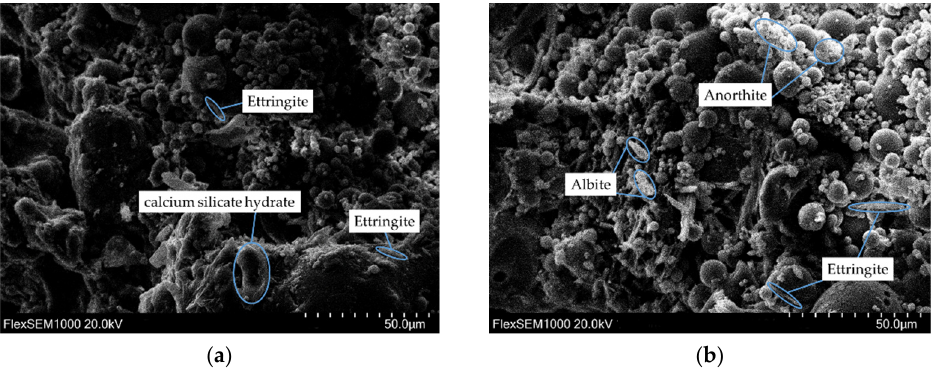
Figure 11. Scanning electron microscopic images of specimens subjected to different erosion environments of ( a ) water and ( b ) sulfate solution.